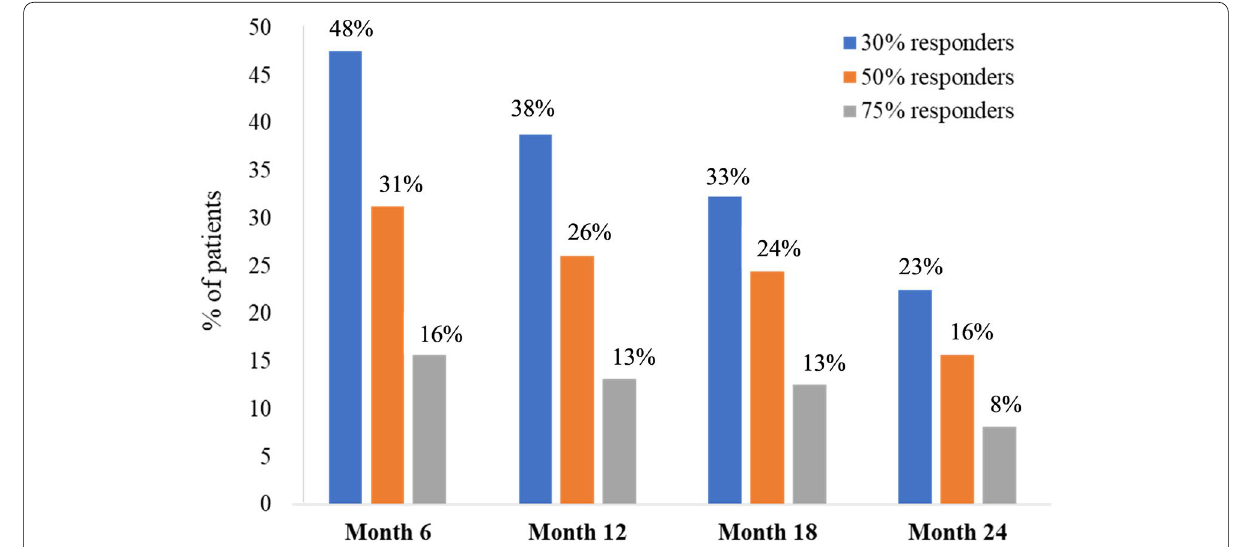
Fig. 2 Percentages of 30, 50, and 75% responders to erenumab at different time